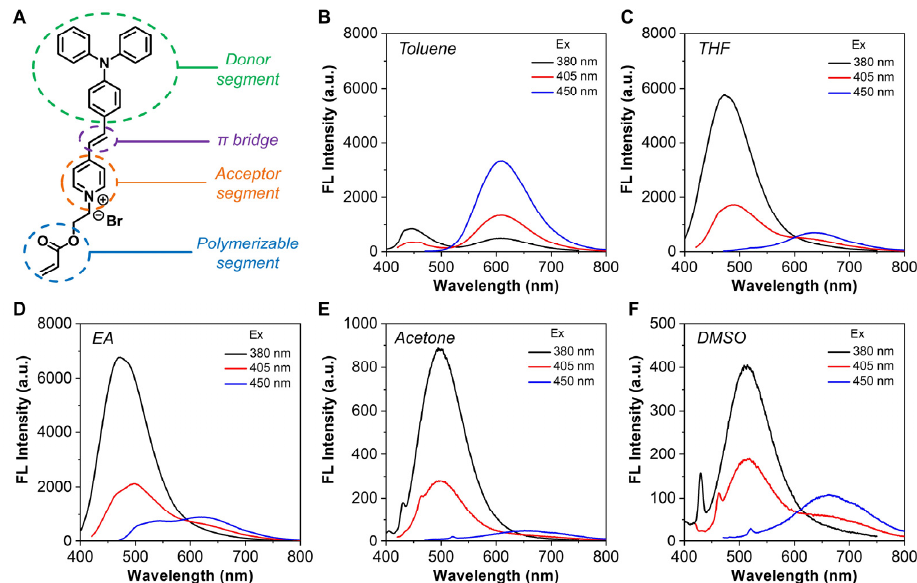
Figure 1. Photophysical characterizations of TVPA. ( A ) Chemical structure of TVPA. ( B – F ) Emission spectra of TVPA in ( B ) toluene, ( C ) THF, ( D ) EA, ( E ) acetone, and ( F ) DMSO, respectively. [TVPA] = 10 µM.